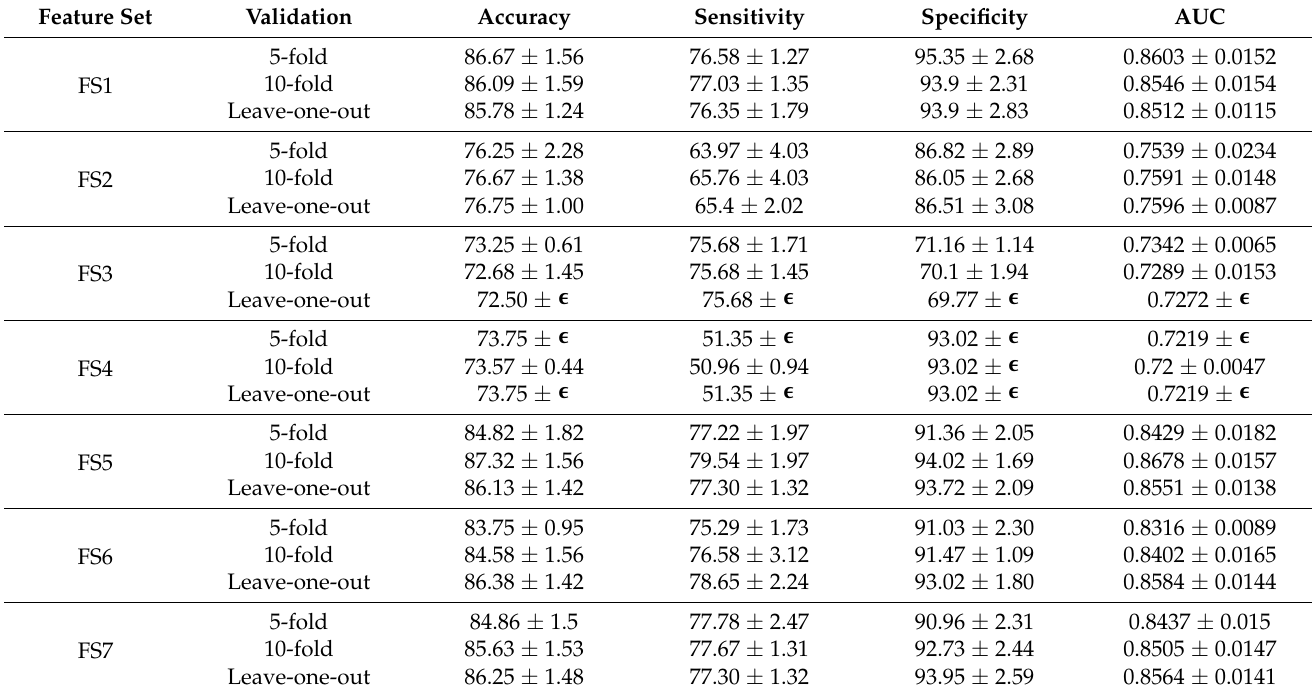
Table 5. Comparison of experimental results of classification accuracy (%), sensitivity (%), specificity (%), and AUC (in terms of mean ± standard deviation) using a RF classification model, where 𝛜 indicates 1.0 × 10 − 5 .